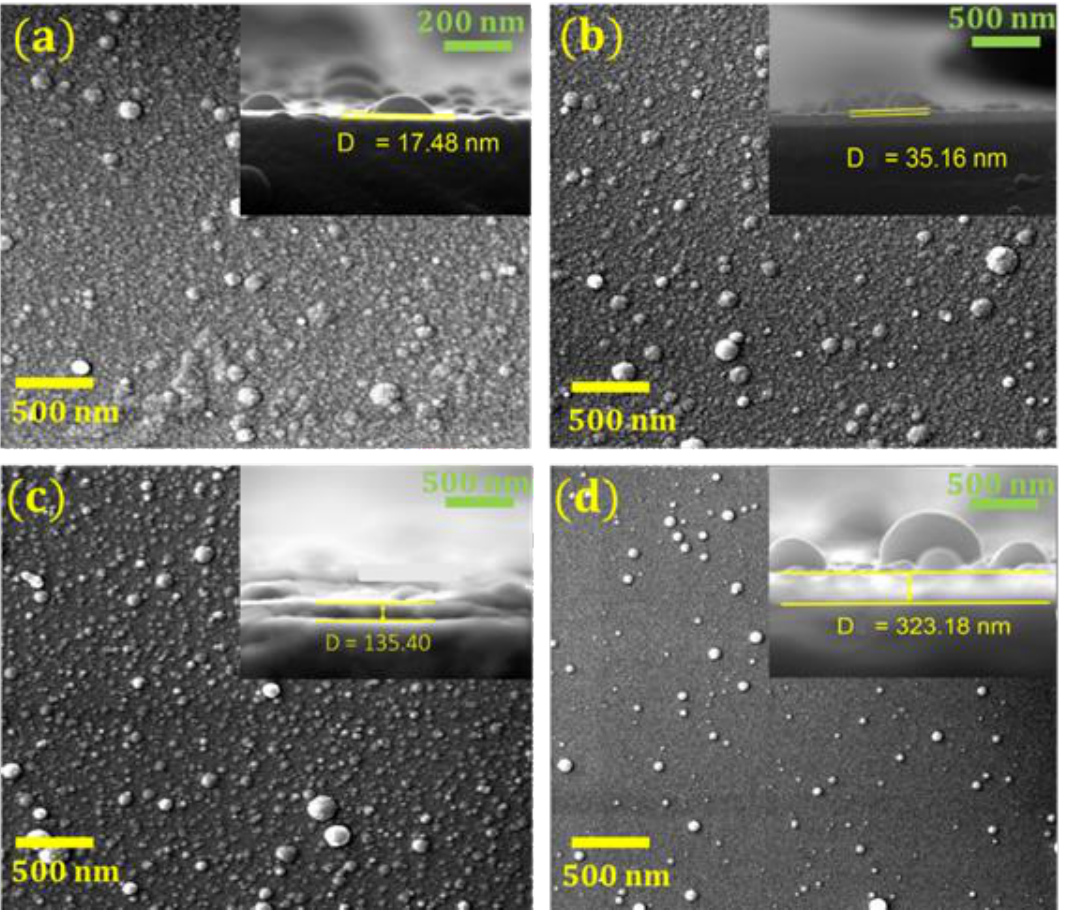
Figure 2. Field emission scanning electron microscope (FESEM) images obtained from the Y/Sialon thin films prepared with PLD at ( a ) room temperature (RT), ( b ) 100 °C, ( c ) 300 °C, and ( d ) 500 °C. Insets correspond to cross-sectional images.